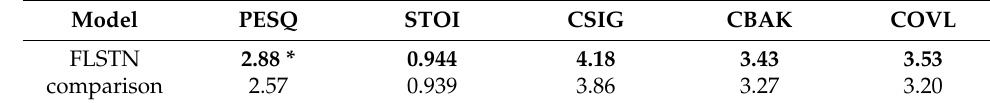
Table 3. FLSTN vs. comparison model.